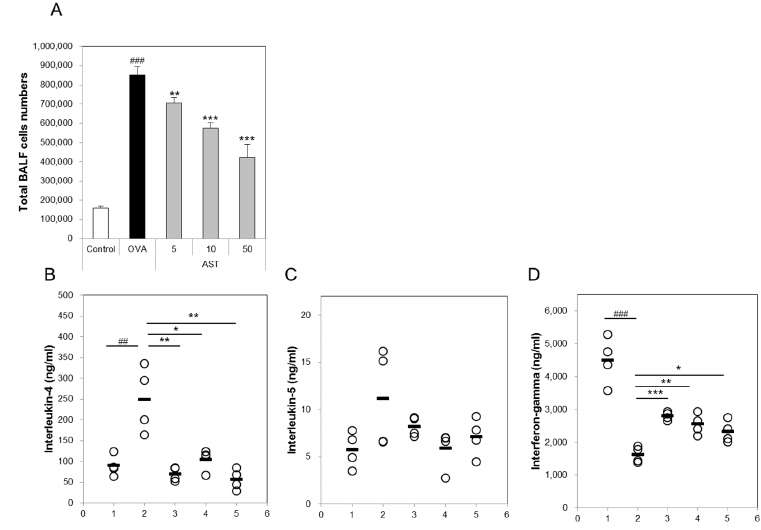
Figure 3. Effects on total cells and Th2-mediated cytokines of AST in BALF. C57BL/6 mice were sensitized and challenged with OVA and AST. In these mice, BALF were collected 24 h after the last challenge. ( A ) The total BALF cells were counted by trypan blue staining; The levels of ( B ) IL-4; ( C ) IL-5; and ( D ) IFN- γ in BALF were measured by ELISA. The data represent four mice per group. ‘ − ’ indicates the mean of four mice. ## p < 0.01 and ### p < 0.001 control vs. OVA. * p < 0.05, ** p < 0.01, and *** p < 0.001 OVA vs. AST. Group numbers (1 = control, 2 = OVA, 3 = AST 5 mg/kg, 4 = AST 10 mg/kg, 5 = AST 50